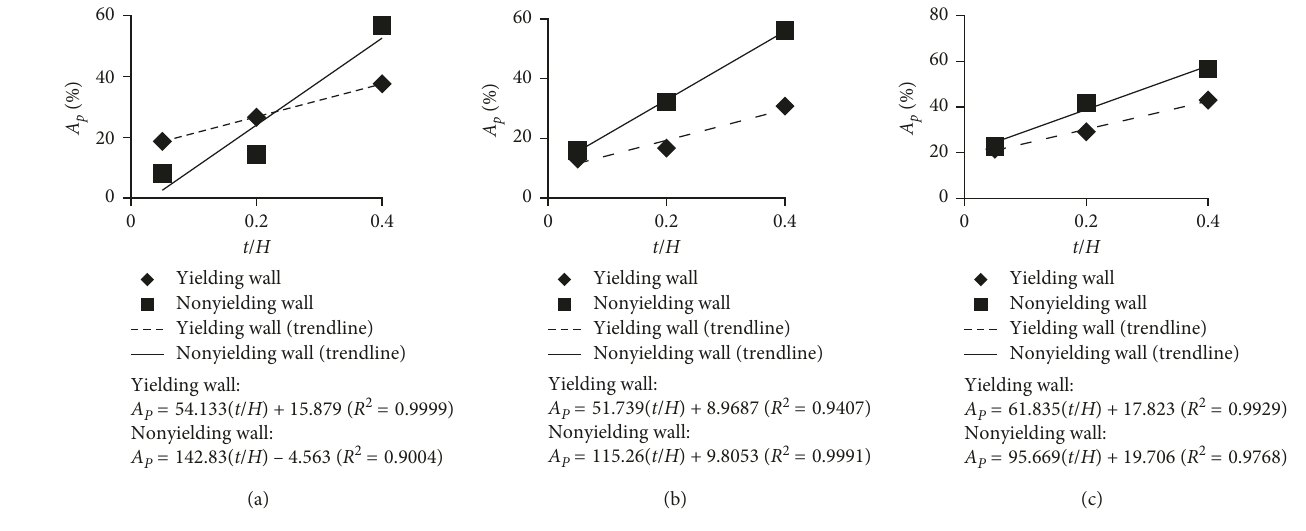
Figure 15: Influence of the EPS20 thickness ratio on reduction of lateral